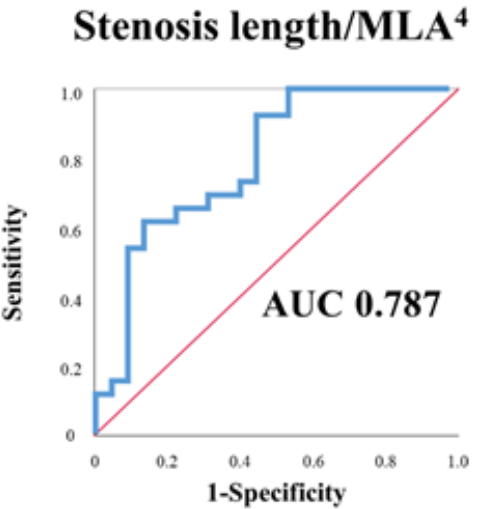
Figure 6. Analysis of the diagnostic efficiency of stenosis parameters alone ( A – D ) or in combination ( E ) in assessing ischemic area > 10% of total myocardium. Optimal cut-off is marked with a red circle. Abbreviations as in previous figures.